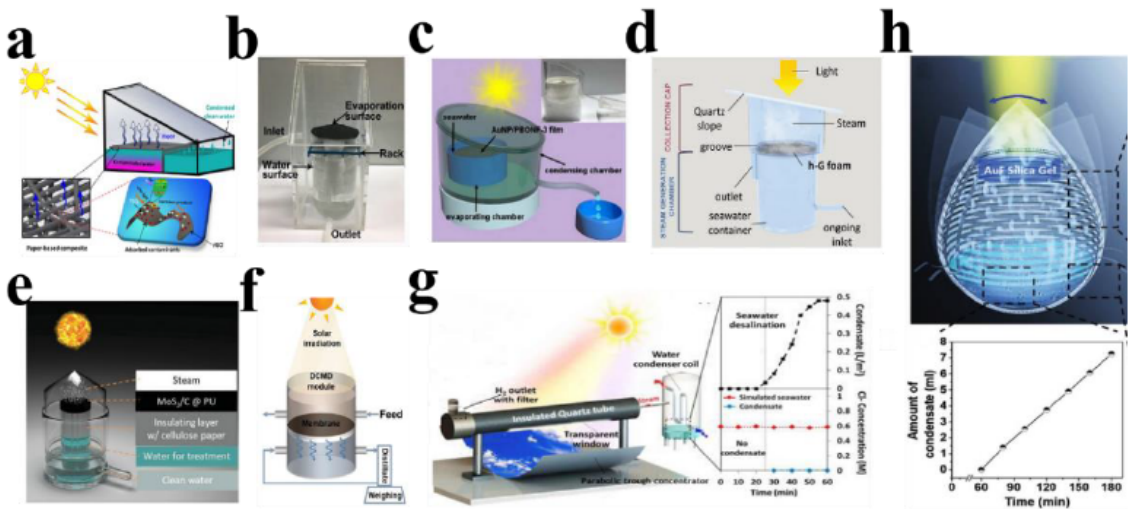
Figure 13: Schematics of solar steam collectors